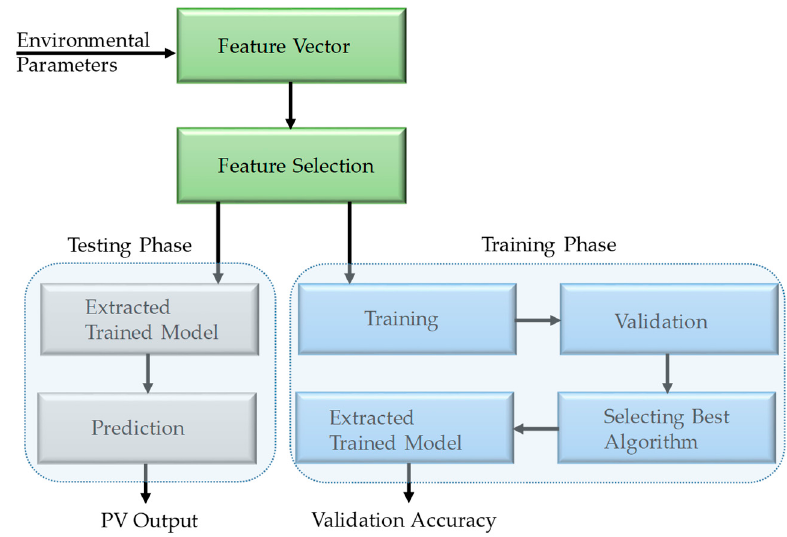
Figure 2. Block diagram of the machine learning-based training and prediction stages.